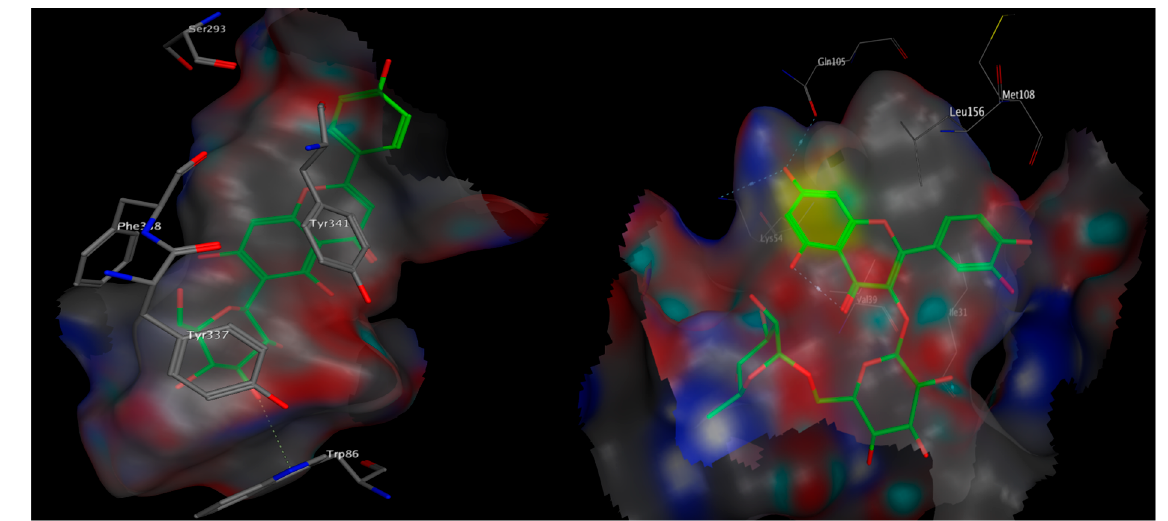
Figure 8. 3D poses of apigenin 6-glucoside docked into the binding site of AChE ( left ) and quercetin 3-rutinoside docked into the binding site of ERK2 ( right ).